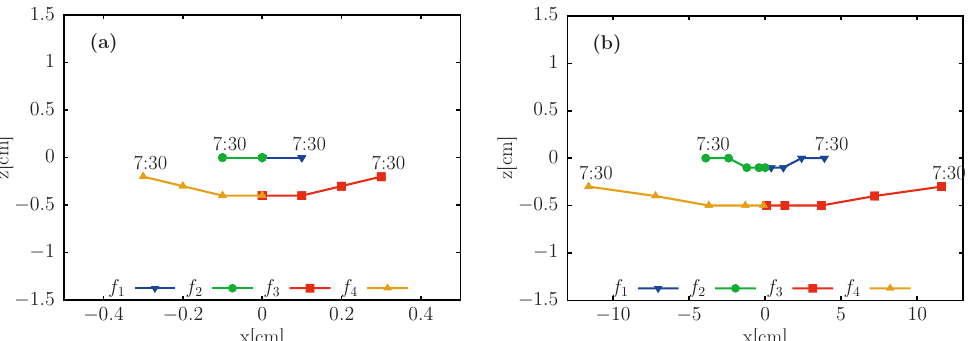
Figure 4. Impact points of the central reflected ray of each facet, for the four mini-heliostats f 1 , f 2 , f 3 and f 4 of the H4 array, on the receiver, for 21 March. The positions are ( a ) 0.75 h (26.25 m) and ( b ) 4 h (140